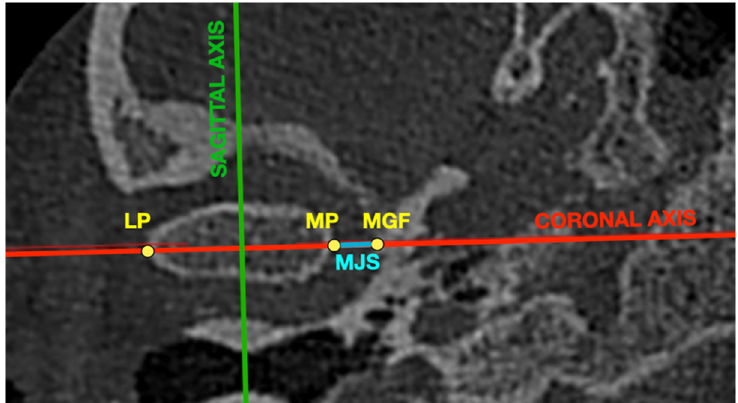
Figure 1. Axial view of the mandibular condyle with marked points and lines presented in Table 2. LP—lateral pole of mandibular condyle, MGF—medial wall of glenoid fossa, MJS—medial joint space, MP—medial pole of mandibular condyle.